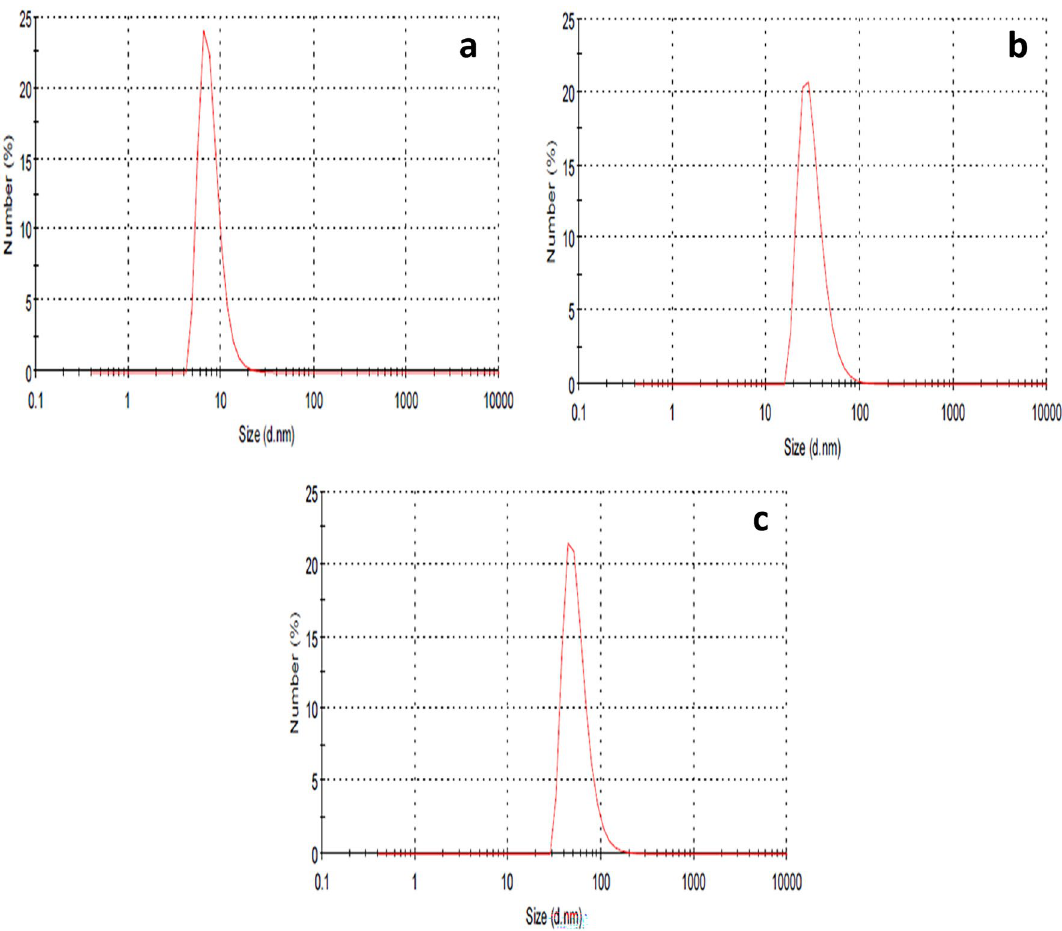
Figure 2. DLS images showing the particle sizes of ( a ) cinnamon AgNPs, ( b ) ginger AgNPs and ( c ) chemical